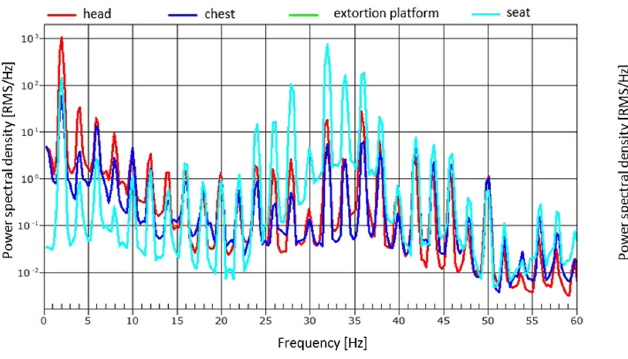
Figure 10: PSD for the 10 Hz excitation for the vertical direction.